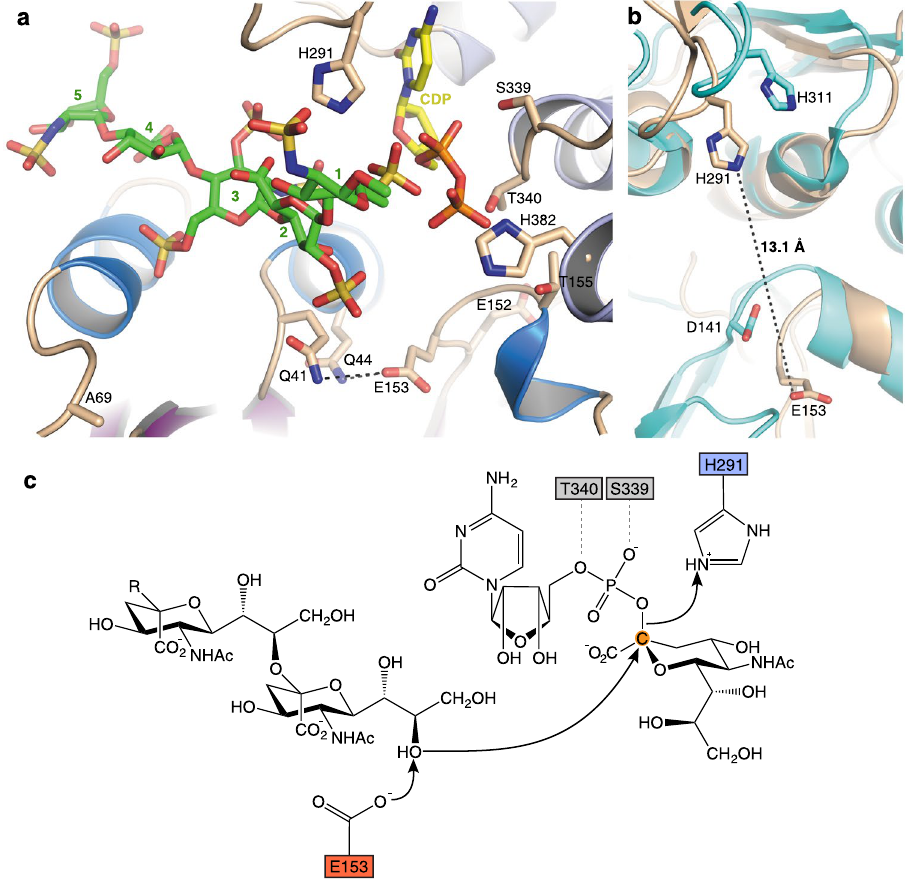
Figure 4. Mh PST active site and identification of the catalytic base. ( a ) Modelled ternary complex by superimposition of the CDP-bound structure and the fondaparinux-bound structure. Mh PST (monomer A) is shown as a ribbon diagram with the same color-coding as in Fig. 1c, CDP is shown as yellow sticks, fondaparinux is shown as green sticks and the five monosaccharide units are indicated. Residues with a supposed role in catalysis are shown in sticks and are labelled. Potential hydrogen bonds between E153 and Q41 and Q44, respectively are indicated as black dashes. The location of the mutation K69A is indicated. ( b ) Superimposition of active site of Mh PST (wheat ribbon diagram) and mono-sialyltransferase PmST1 in open conformation (PDB: 3s44, cyan ribbon diagram). The catalytic acid and base are shown in sticks and are labelled for both enzymes, and the distance between E153 and H291 is indicated for Mh PST. ( c ) S N 2-like reaction mechanism of Mh PST. The catalytic base E153 (red box) abstracts a proton from the C8 ′ hydroxyl group of the sialic acid acceptor concerted with the nucleophilic attack on the anomeric C2 ′ carbon (orange circle) of the CMP sialic acid donor substrate, thereby generating an α -2,8 glycosidic linkage. The resulting negatively charged CMP leaving group is stabilized by H291 (blue box) assisted by S339 and T340 (grey boxes). R = α -2,8- linked